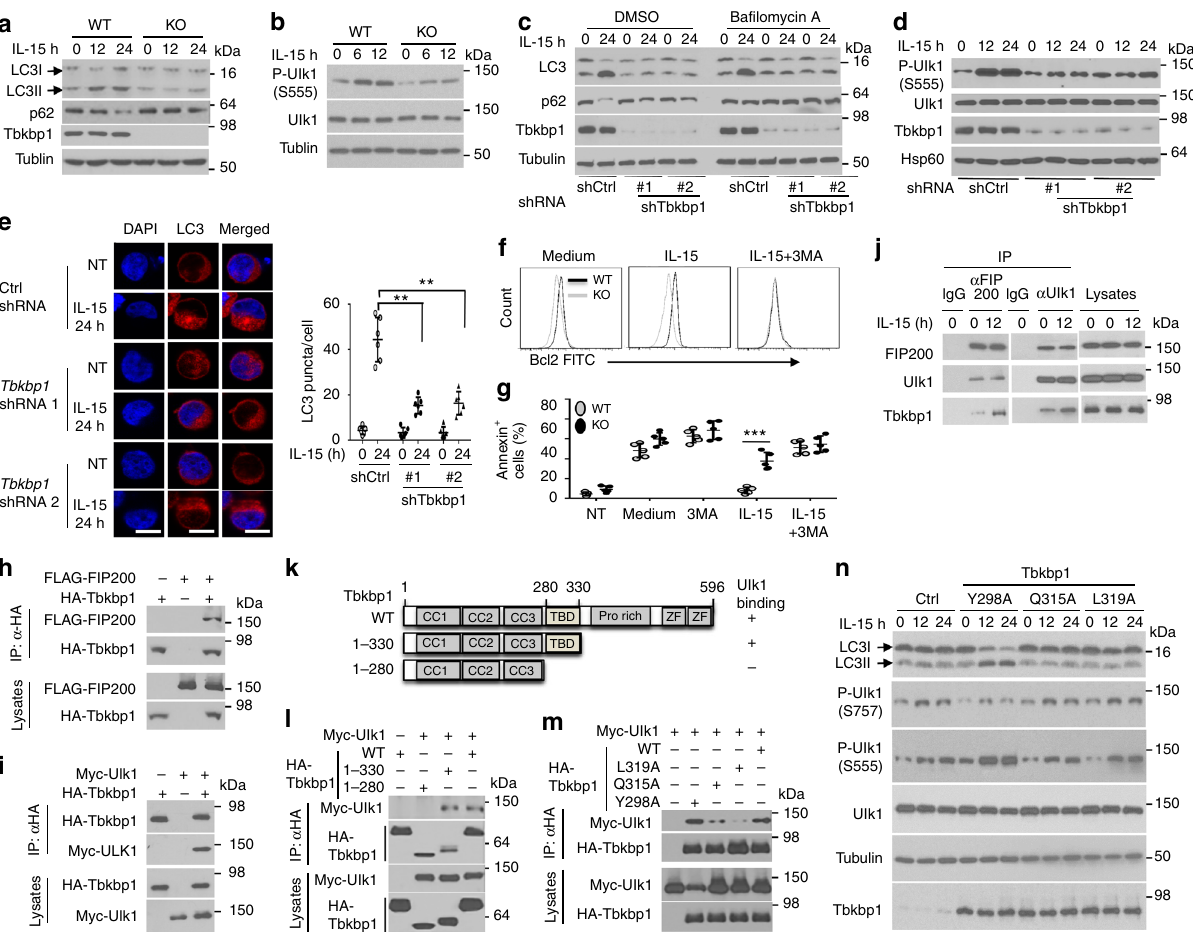
Fig. 6 Tbkbp1 mediates IL-15-stimulated autophagy in NKT cells. a – d IB analysis of LC3 modi fi cation and p62 degradation ( a , c ) and Ulk1 phosphorylation ( b , d ) in whole-cell lysates of IL-15-stimulated WT or Tbkbp1 -KO thymic NKT cells ( a , b ) or NKT hybridoma cells transduced with a non-silencing control shRNA (shCtrl) or two different Tbkbp1 -speci fi c shRNAs that were stimulated with IL-15 ( d ) or IL-15 together with DMSO or ba fi lomycin A ( c ). e Confocal microscopic analysis of LC3 puncta, DAPI (nuclear staining), and merged picture of untreated (NT) or IL-15-stimulated control or Tbkbp1 -knockdown NKT hybridoma cells. Data are presented as representative images (left) and summary graph of quanti fi ed LC3 puncta (right). Scale bar, 5 μ m. f Flow cytometric analysis of intracellular Bcl2 expression level in WT or Tbkbp1 -KO thymic NKT cells cultured for 2 days with medium control, IL-15, or IL-15 plus the autophagy inhibitor 3MA. g Summary graph of fl ow cytometric analysis of AnnexinV + apoptotic cells in enriched thymic NKT cells that were either untreated (NT) or cultured for 1 day with the indicated agents. h , i Co-IP analysis of Tbkbp1-FIP200 ( h ) or Tbkbp1-Ulk1( i ) interaction (upper) and direct IB assays (lower) using lysates of HEK293 cells transfected with the indicated expression vectors. j IB analysis of the indicated proteins in IP samples of control IgG, anti-FIP200, or anti-Ulk1 or direct lysates of NKT hybridoma cells that were stimulated as indicated. k Schematic of Tbkbp1 WT and mutants showing the coiled-coil domains (CCs), TBK-binding domain (TBD), proline-rich domain, and zinc fi ngers (ZF). l , m Co-IP analysis of Ulk1 binding with the indicated Tbkbp1 mutants (upper) and direct IB assays (lower) using HEK293 cells transfected with Myc-ULk1 along with Tbkbp1 truncation mutants ( l ) and point mutants ( m ). n IB analysis of the indicated phosphorylated (P-) or total proteins in whole-cell lysates of Tbkbp1-knockdown NKT hybridoma cells reconstituted with a vector control (Ctrl) or the indicated Tbkbp1 point mutants, stimulated as indicated. Data are representative of three or more independent experiments. **P < 0.01; ***P < 0.001. Two-way ANOVA ( e ), Student ’ s t -test ( g